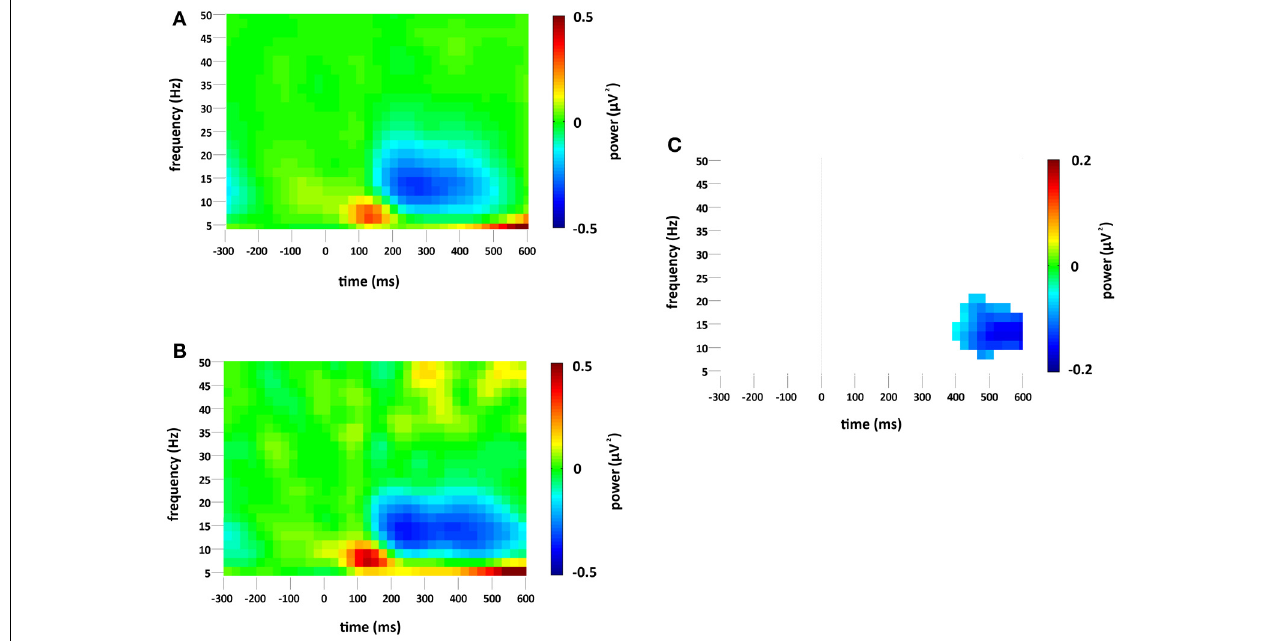
(C) significant difference values (i.e., deviant minus standard, p < 0 . 05) after Monte Carlo permutation correction for multiple comparisons. Non-significant differences are masked in white.